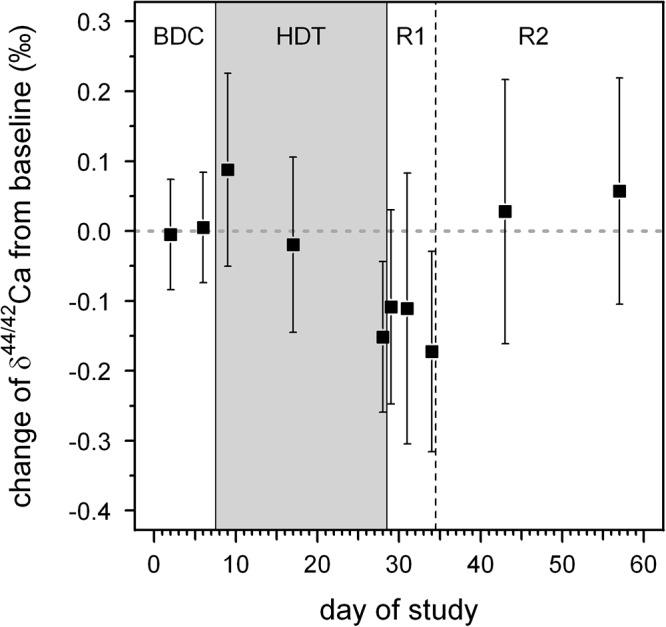
Average changes in δ44/42Ca from baseline values for all subjects as a function of day during our bed rest study. The baseline value is represented by the average δ44/42Ca of all subjects during the BDC period (BDC-6 and BDC-2). The phases of the study are: BDC: pre-bed rest baseline data collection, HDT: head-down-tilt bed rest, R1: inpatient regeneration and R2: outpatient regeneration (follow-up examinations).